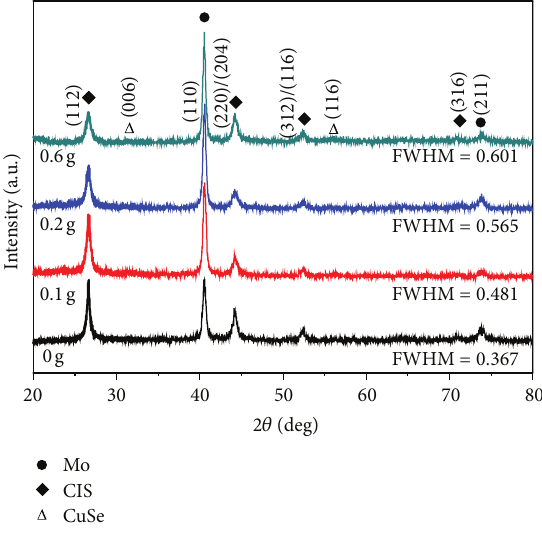
Figure 5: XRD patterns of the CIS absorber layers as a function of extra Se content; the selenization temperature was 550 ∘